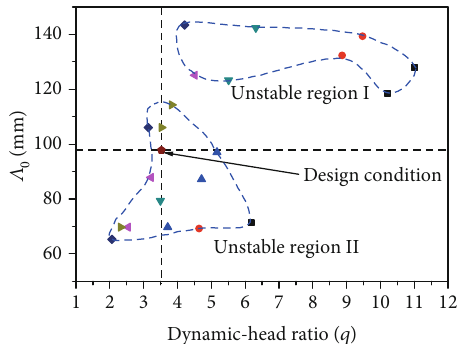
Figure 8: Instability region boundaries plotted on the coordinate planes of q − Λ o